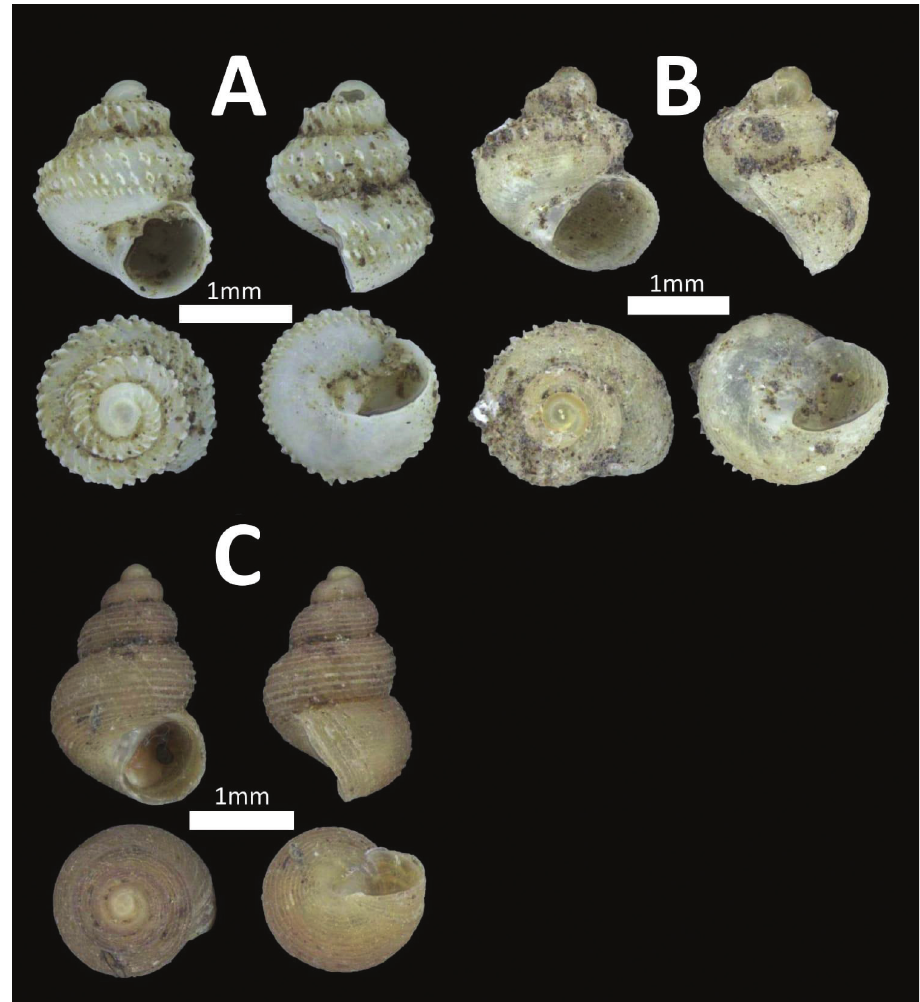
Figure 8. FAMILY HYDROCENIDAE. A Georissa saulae (BOR/MOL 27) B Georissa scalinella (BOR/ MOL 41) C Georissa williamsi (BOR/MOL